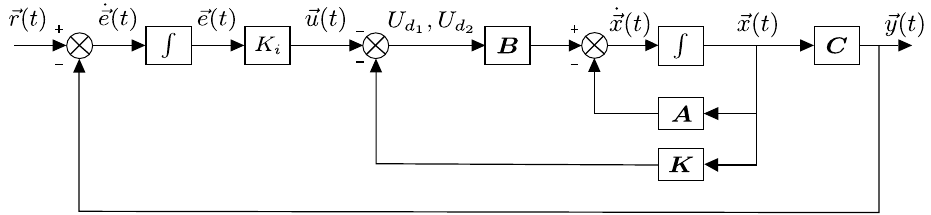
Figure 7. IBC hybrid LQR-I control block